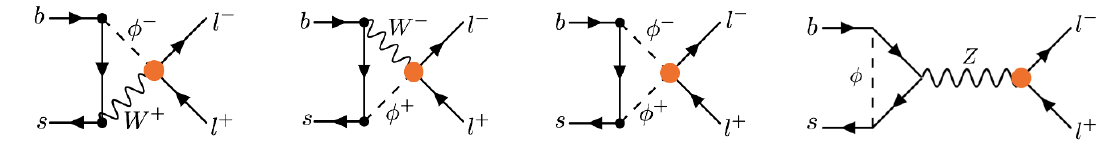
and Q He operators. The Hl